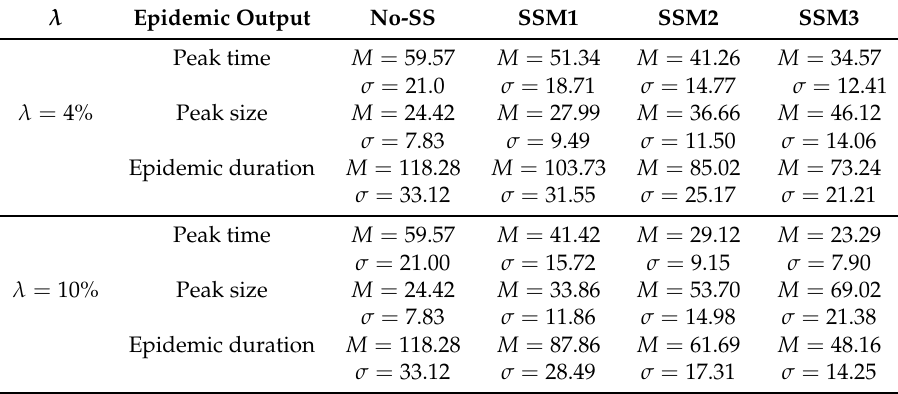
Table 2. Mean (M) and standard deviation ( σ